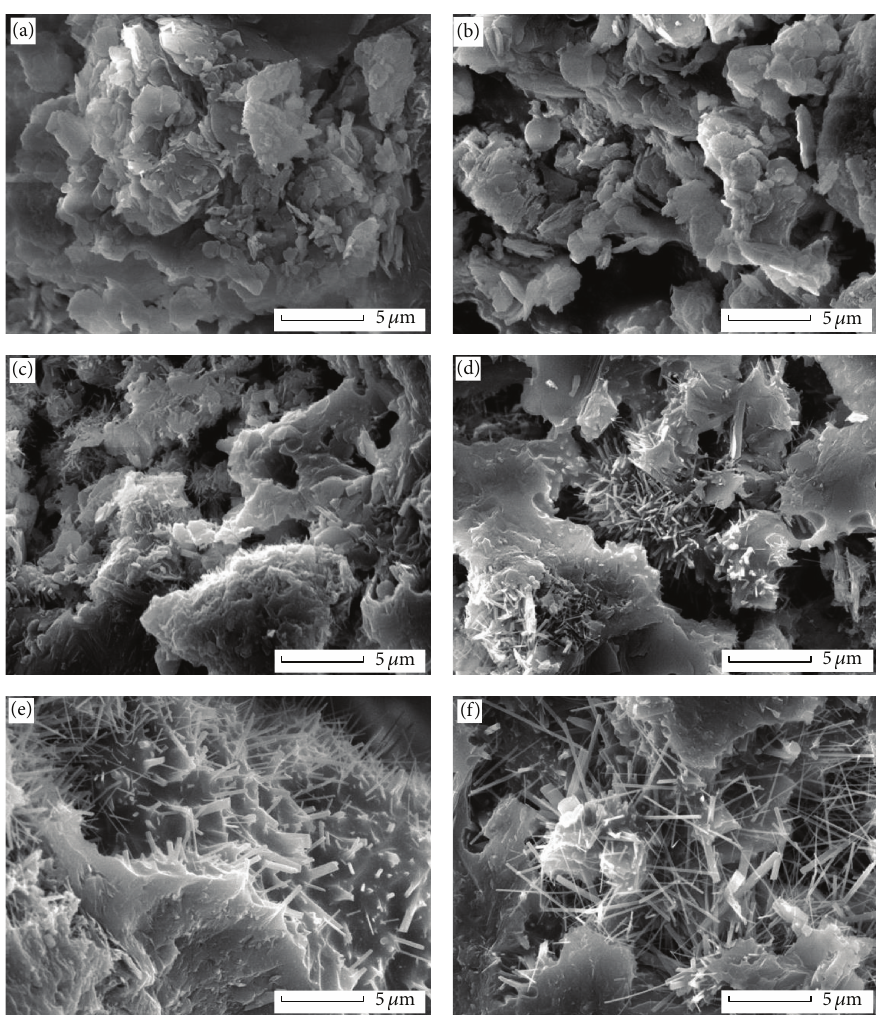
Figure 4: Microstructures of glass ceramic samples isothermally heated at 820 ∘ C with (a) 0 h, (b) 10min, (c) 0.5 h, (d) 1h, (e) 2 h, and (f) 4